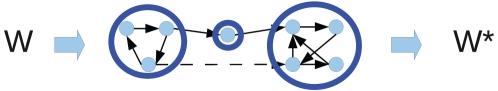
Down-ranking of unnecessary feed-forward edges.The thick rings highlight the strongly connected components of . The dashed edge is removed from the network.